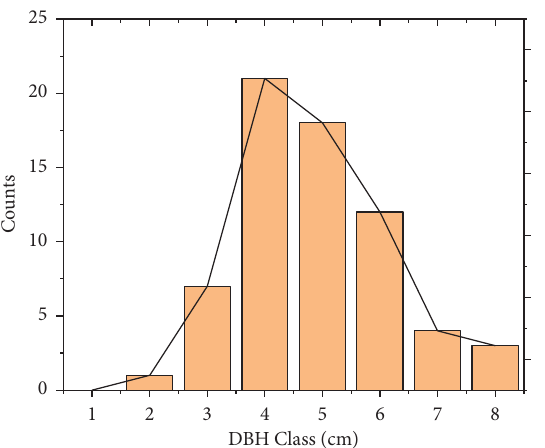
Figure 7: Crown cover diameter (m) class distribution (1 � < 3,